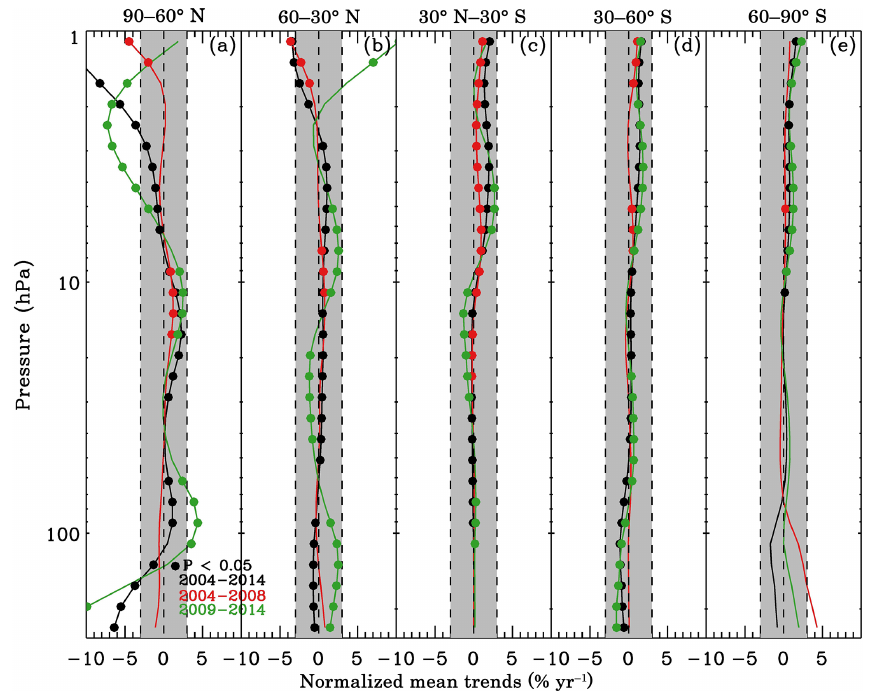
Figure 10. Linear regression trends of relative OMI–MLS biases as a function of altitude for five latitudes bands during three time periods: 2004–2014 (black), 2004–2008 (red), and 2009–2014 (green). Solid circles indicate significant trends (with p value less than 0.05). The gray areas indicate the range of − 3% and 3% in each